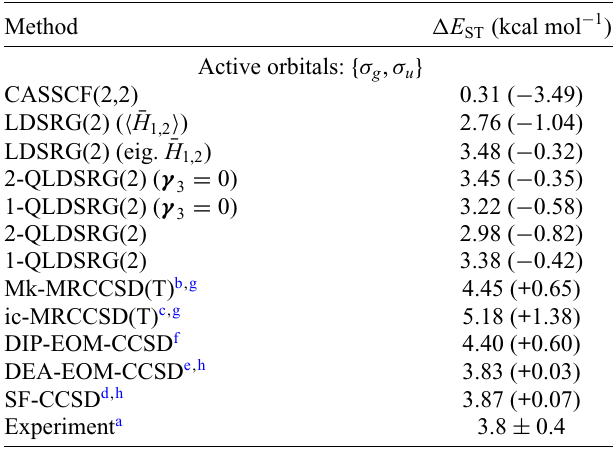
TABLE III. Adiabatic singlet-triplet splittings ( (cid:8) E ST = E T − E S ) (in kcal mol − 1 ) of para -benzyne computed with the LDSRG(2) and QLDSRG(2) in the cc-pVTZ basis [85] with . The data in parentheses the flow parameter value s = 1.0 E − 2 h show the difference with respect to the experimental value of − 1 ). All LDSRG(2) and QLDSRG(2) results (cid:8) E ST (in kcal mol include a zero-point vibrational energy (ZPVE) correction equal to + 0.30 kcal mol − 1 (see Ref. [103]). The geometries are taken from Ref. [104]. We use CASSCF(2,2) optimized orbitals for all computations of the singlet state and ROHF orbitals for the triplet state. For the LDSRG(2), the expectation value of the energy is designated with “ (cid:8) ¯ H 1,2 (cid:9) ,” while the lowest eigenvalue is indicated with “eig. ¯ H 1,2 .” For the QDSRG methods, we report = 0” use an approximate two sets of data. Those labeled “ γ 3 ˜ λ ˜ λ three-body cumulant reconstructed from approximate 1 and 2 . All literature results listed here for comparison use the same cc-pVTZ basis.